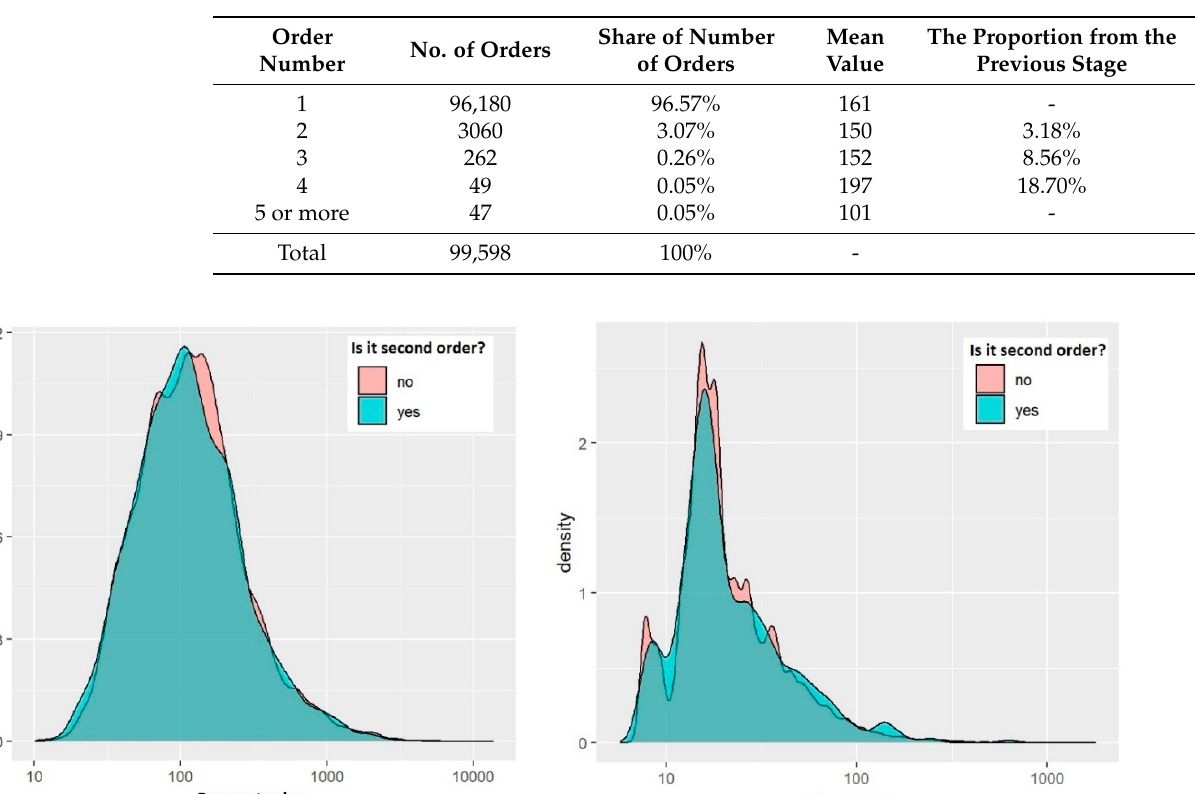
Figure 5. Scatterplot of transportation value and order value. Note: The logarithm of both axes is used for better plot clarity.